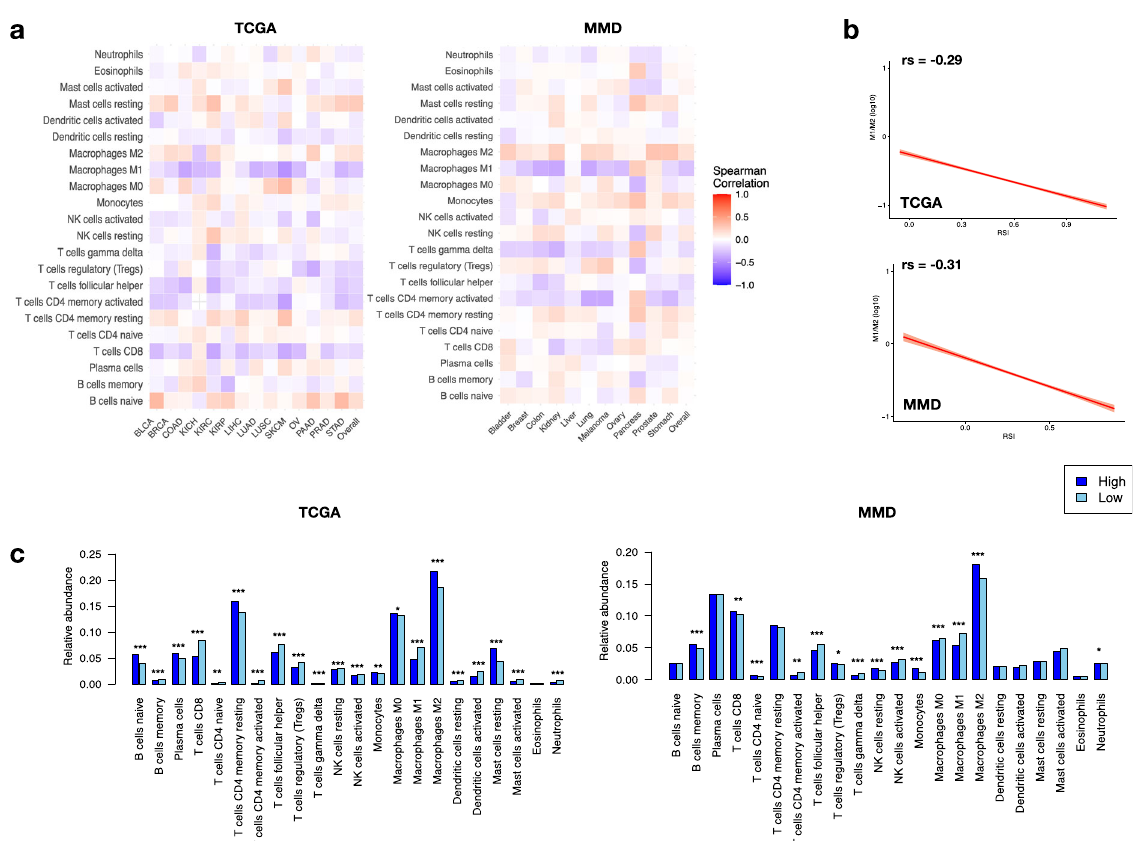
Fig. 2 RSI and immune cell in fi ltrates in tumours. a Heatmaps showing Spearman ’ s correlation between RSI and the relative fraction of 22 immune cell types obtained from CIBERSORT. b Correlations between RSI and M1/M2 ratio. Relative portion of M1 and M2 macrophages obtained from (M1/M2) was log2 (M1/M2) transformed for plotting. c Distribution of relative abundance of the 22 immune cell subtypes between RSI-High and RSI-Low tumours in TCGA (upper panel) and MMD (lower panel). M1: Macrophage M1; M2: macrophage M2. Mann – Whitney U-test *** p < 0.001, ** p < 0.01, * p <